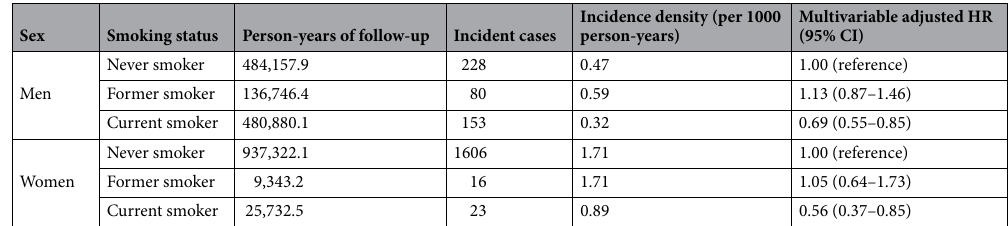
Table 2. Development of thyroid cancer according to smoking